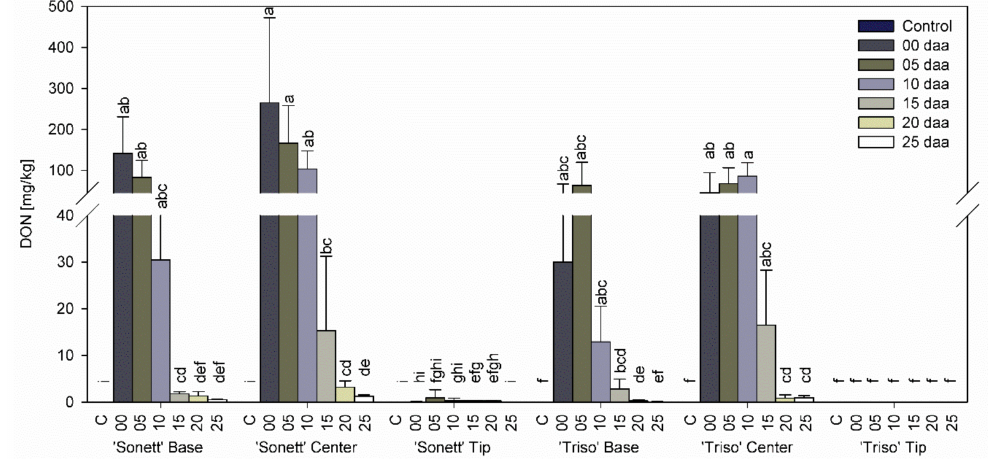
Figure 3. Deoxynivalenol content in the tips, centers, and bases of the spikes of spring wheat varieties ‘Sonett’ and ‘Triso’ after inoculation of the central spikelets of the spike with Fusarium graminearum at different days after anthesis (daa), Kruskal–Wallis test ( p < 0.0001); n = 6; treatments with the same letters at the level of the variety are not significantly